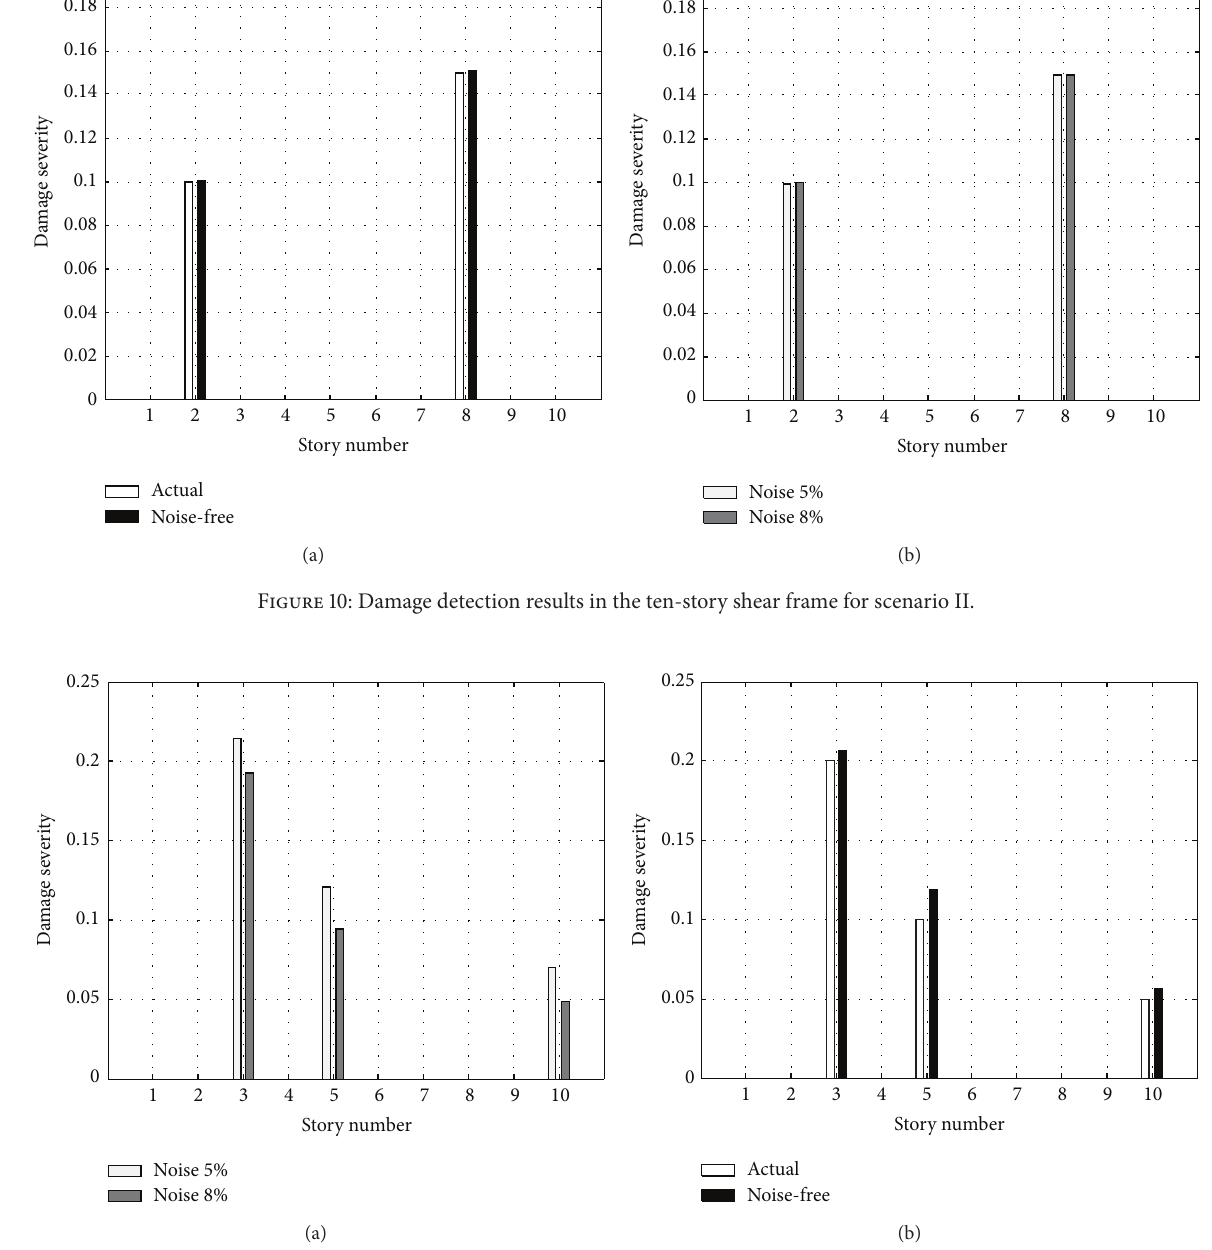
Figure 11: Damage detection results in the ten-story shear frame for scenario